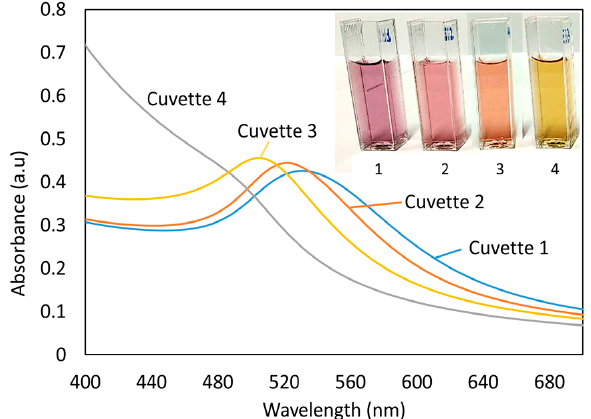
Figure 2. Change of Localized Surface Plasmon Resonances (LSPR) wavelength of PAA-AuNP dispersion with different Hg concentration. Cuvette 1: as prepared only with AuNPs. Cuvette 2: PAA-AuNP + DMAB. Cuvette 3: PAA-AuNP + DMAB and mercury (2.7 ppb). Cuvette 4: PAA-AuNP + DMAB and mercury (27 ppb).